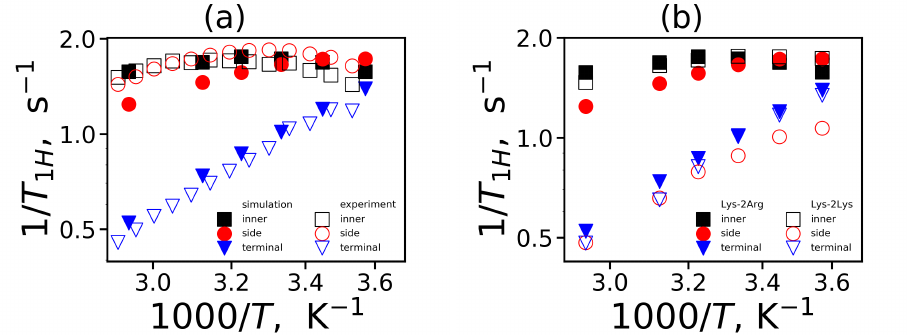
Figure 11. The 1 H NMR spin-lattice relaxation rate 1/ T 1 H as a function of inverse temperature 1000/ T for the inner, side and terminal CH 2 groups at the fixed frequency ω H /2 π = 400 MHz: ( a ) from the simulation and experimental data for Lys-2Arg, ( b ) from the simulation data for Lys-2Arg and